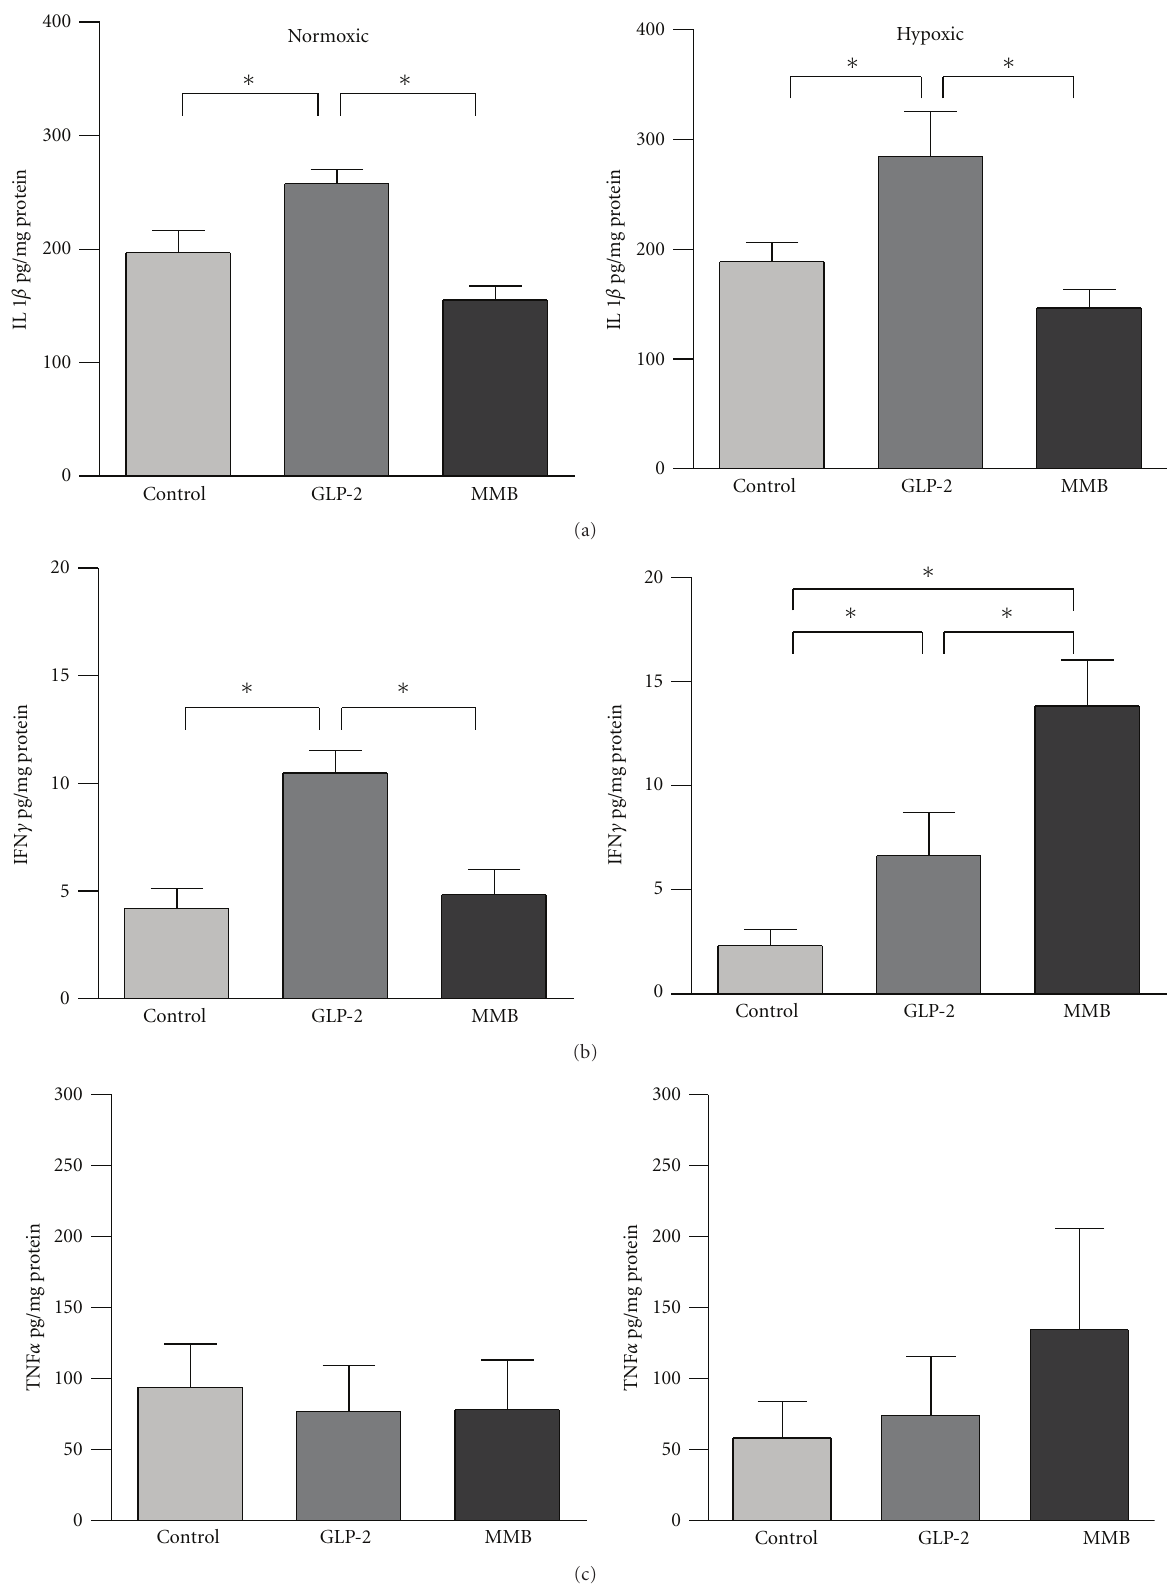
Figure 4: Pro-inflammatory cytokines: IL1 β (a), IFN γ (b) and TNF α (c) as measured by ELISA and normalized to protein content in anastomosed colon from normoxic and hypoxic animals treated with GLP-2, mimetibody or control. Data: mean ± SEM, n = 7 or more per group, ∗ P < . 05 by